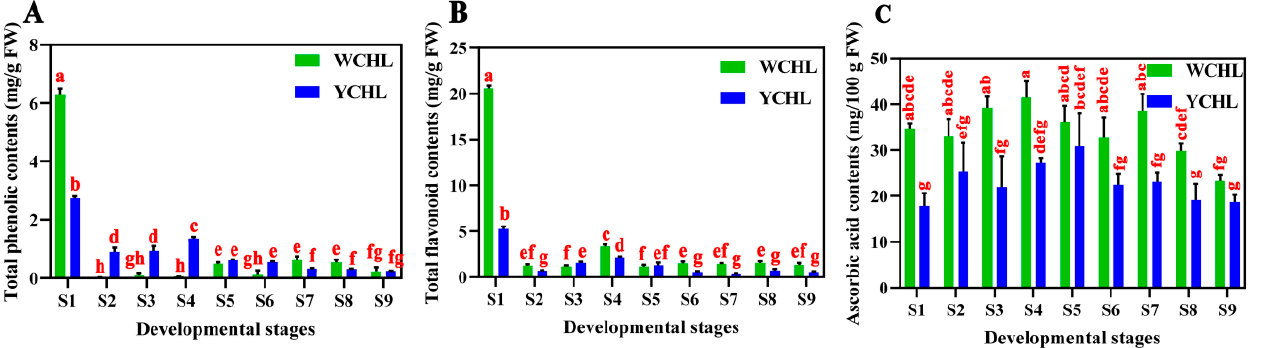
Figure 2. Changes in contents of total phenol ( A ), flavonoid ( B ), and ascorbic acid ( C ) in pulps during fruit developmental stages of ‘WCHL’ and ‘YCHL’ pitayas. Data represent the mean ± S.E. of three biological replicates. Lowercase is indicated the comparison between groups using one-way ANOVA (Duncan test, p < 0.01).